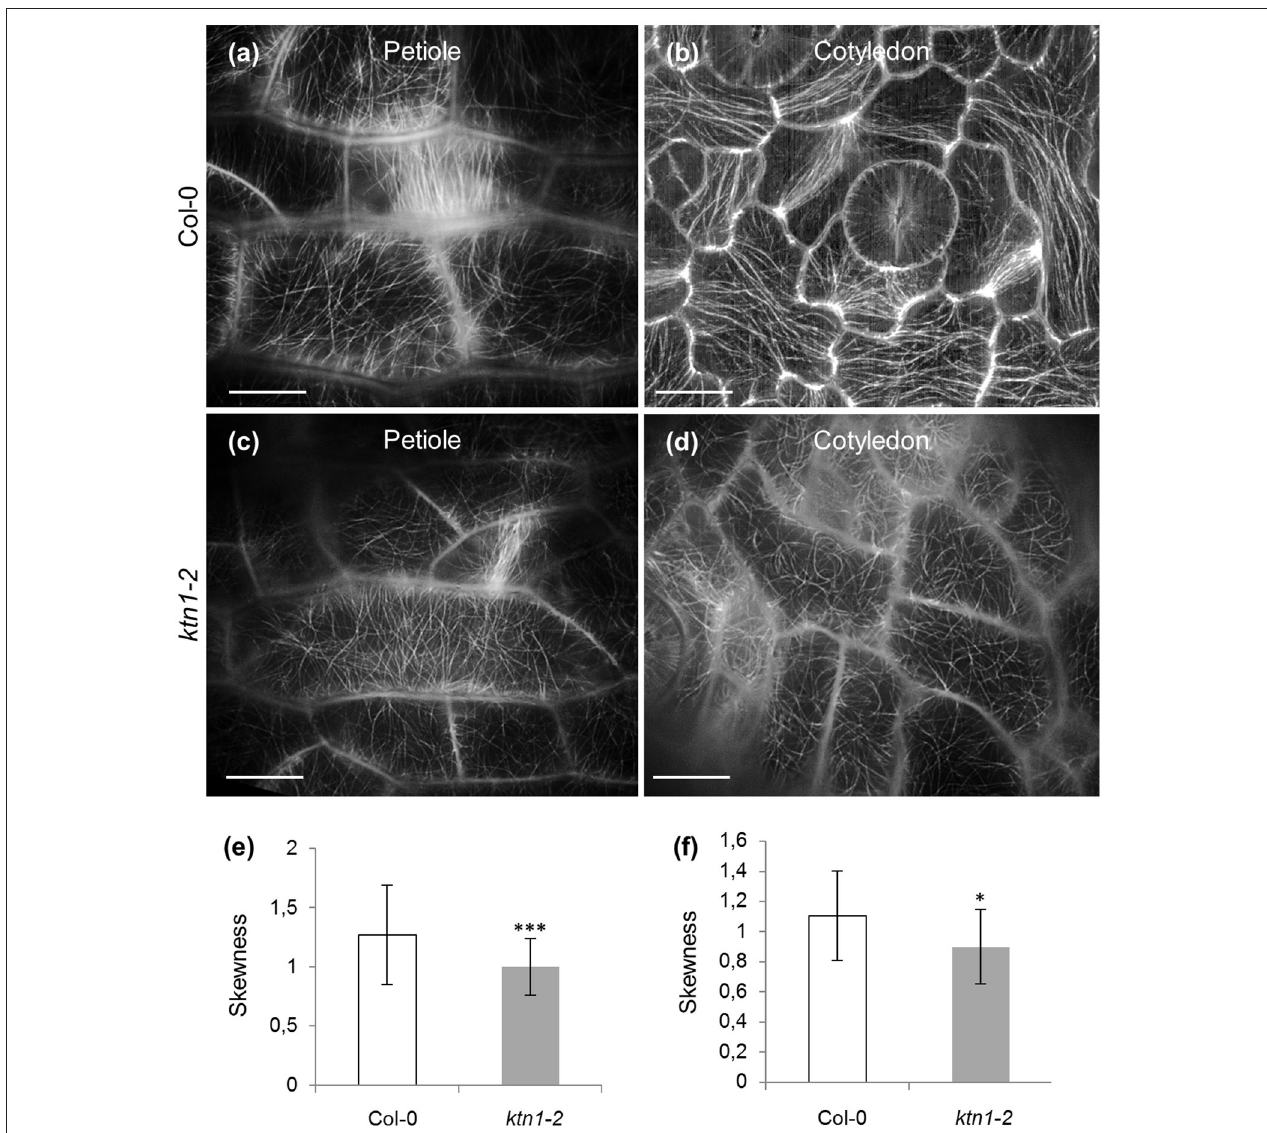
FIGURE 2 | Microtubule skewness in Col-0 and ktn1-2 petiole and cotyledon epidermal cells expressing a GFP-TUA6 microtubule marker after SIM 2D imaging. (a–d) Examples of microtubule organization in petiole (a,c) and cotyledon (b,d) epidermal cells of Col-0 (a,b) and ktn1-2 (c,d) . (e) Skewness of petiole epidermal cells of Col-0 and ktn1-2 (*** p < 0.001; N = 49 cells for Col-0 and N = 34 for ktn1-2 ). (f) Skewness of cotyledon epidermal cells of Col-0 and ktn1-2 (* p < 0.05; N = 28 cells for Col-0 and N = 26 for ktn1-2 ). Scale bars: 10 µ m.